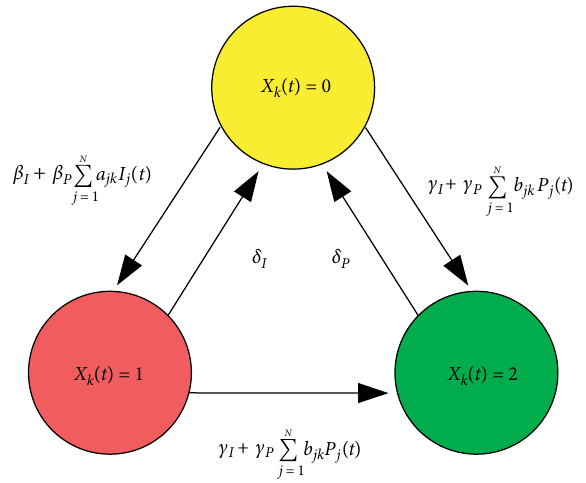
Figure 1: Diagram of assumptions (A